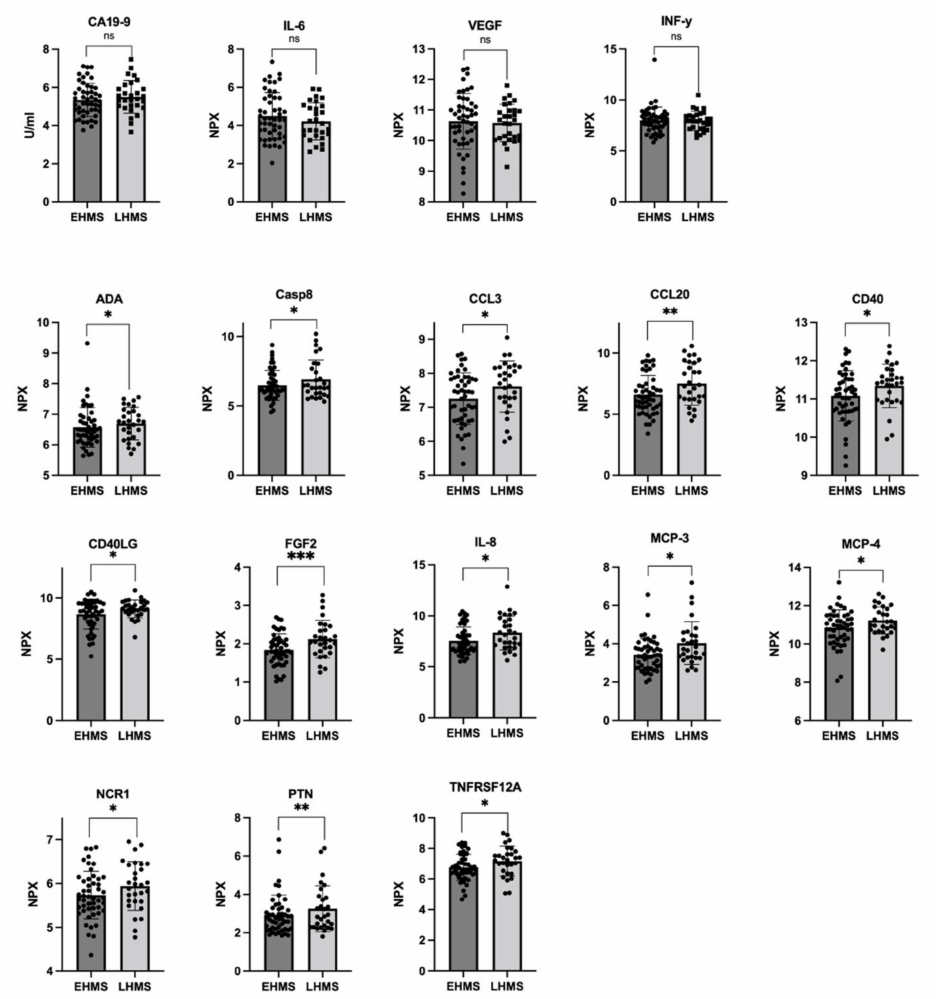
Figure 4. Selected markers determined by Olink ® analysis in serum from PDAC patients with early hepatic metastatic spread (EHMS, n = 49) or late hepatic metastatic spread (LHMS, n = 29). CA19-9 (previously also analyzed by Roche Assay), IL-6, VEGF, and IFN- γ (previously also analyzed by LEGENDplex TM ) were analyzed by Olink ® . Using Olink ® , the following other parameters were identified at different levels in the two cohorts. ADA: Adenosine Deaminase; CA19-9: Carbohydrate antigen 19-9; CASP8: Caspase 8; CCL3: chemokine ligand 3; CCL20: chemokine ligand 20; CD4: clus- ter of differentiation 4; CD40LG: cluster of differentiation 40 ligand; FGF2: Fibroblast Growth Factor 2; IL-6: Interleukin-6; IL-8: Interleukin-8; IFN- γ : Interferon- γ ; MCP-3: Monocyte Chemoattractant Protein-3; MCP-4: Monocyte Chemoattractant Protein-4; NCR1: Natural Cytotoxicity triggering Re- ceptor 1; PTN: Pleiotrophin; TNFRSF12A: Tumor Necrosis Factor Receptor Superfamily Member 12A; VEGF: Vascular Endothelial Growth Factor. Statistical analysis was performed using Mann–Whitney U test for non-normally distributed data. * p -value < 0.05, ** p -value < 0.005, *** p -value <